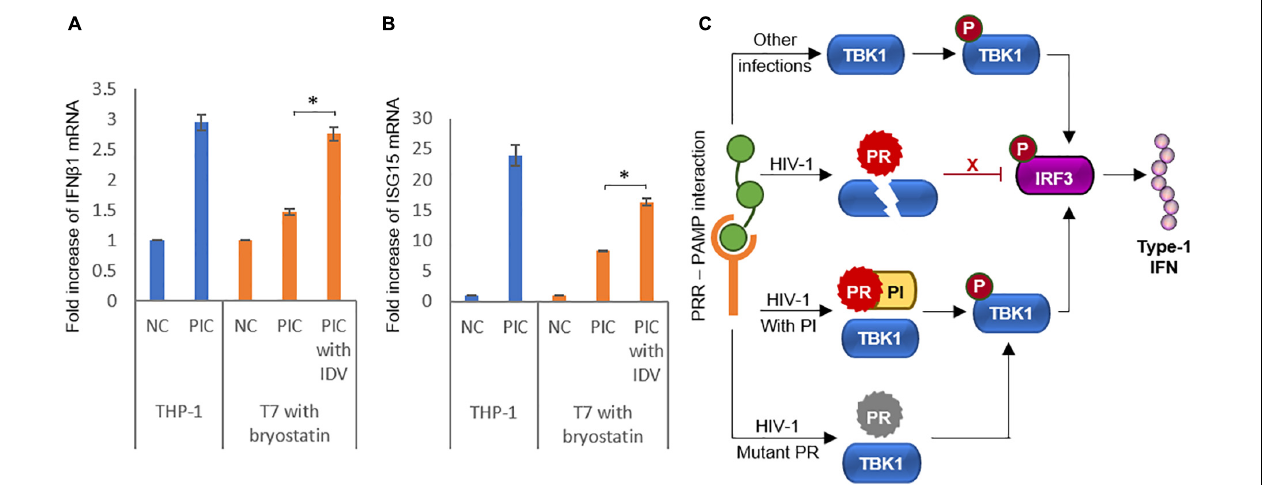
FIGURE 6 | Protease inhibitors rescue interferon activity in infected cells. (A) HIV-1 latently infected monocytic cell line T7 was reactivated with 25 ng/ml bryostatin-1 and IFN β 1 mRNA was detected by RT-qPCR in poly(I:C) treated cells in the presence or absence of the protease inhibitor indinavir. Uninfected THP-1 cells were used as positive control. Bars represent the mean value of three replicates. NC Negative control, PIC Poly(I:C), IDV Indinavir. ∗ indicates p -value < 0.05. (B) HIV-1 latently infected monocytic cell line T7 was reactivated with 25 ng/ml bryostatin-1 and ISG15 mRNA was detected by RT-PCR in poly(I:C) treated cells in the presence or absence of the protease inhibitor indinavir. Uninfected THP-1 cells were used as positive control. Bars represent the mean value of three replicates. NC Negative control, PIC Poly(I:C), IDV Indinavir. ∗ indicates p -value < 0.05. (C) Schematic representation of the findings of the study summarizing the role of HIV-1 protease in the interferon secretion